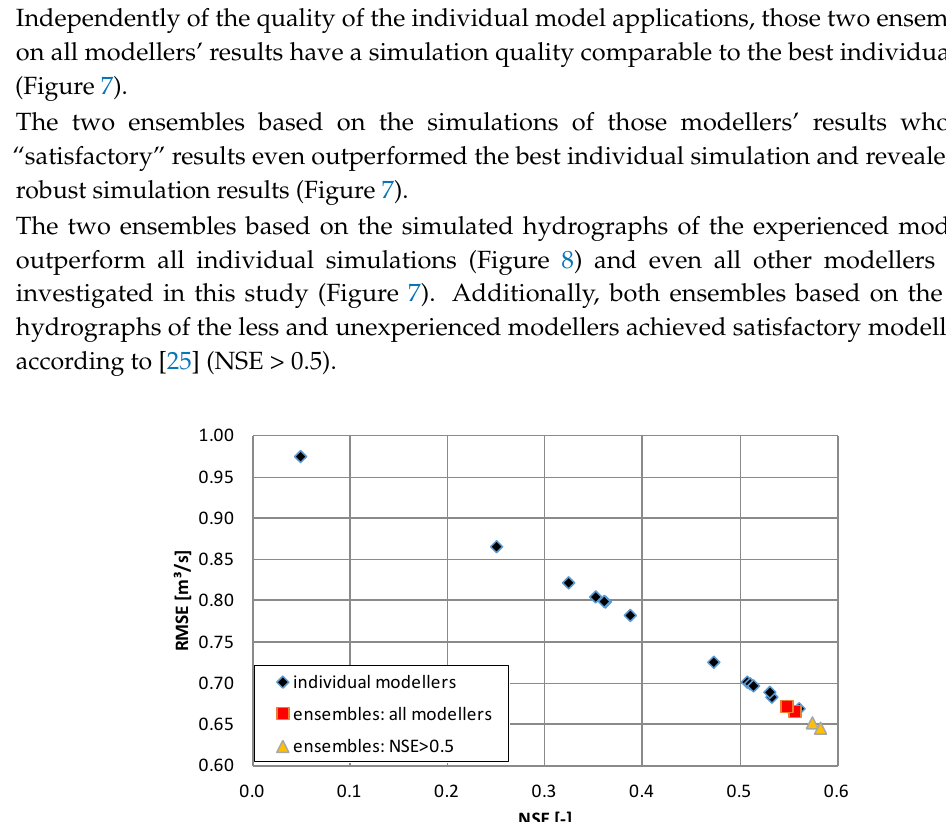
Figure 8. Comparison of individual model applications (blue diamonds) against model(er) ensembles (median, mean) based on the results of the experienced modellers (red squares) compared to the less or even unexperienced modellers (yellow triangles). For graphical reasons, the results of one modeller are not shown who achieved an NSE value of − 45.9.